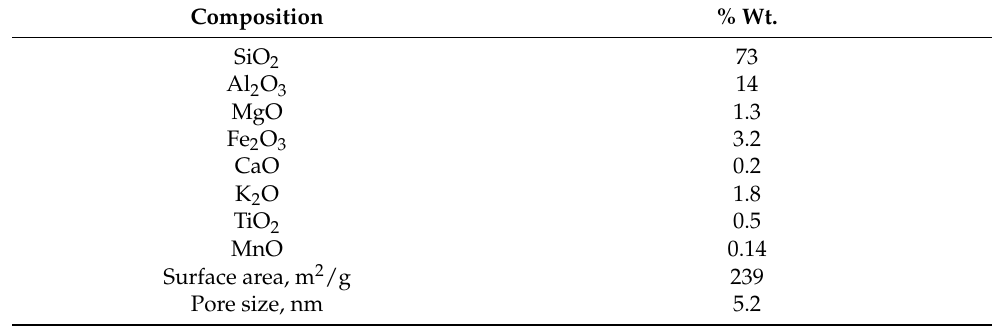
Table 1. Properties of montmorillonite